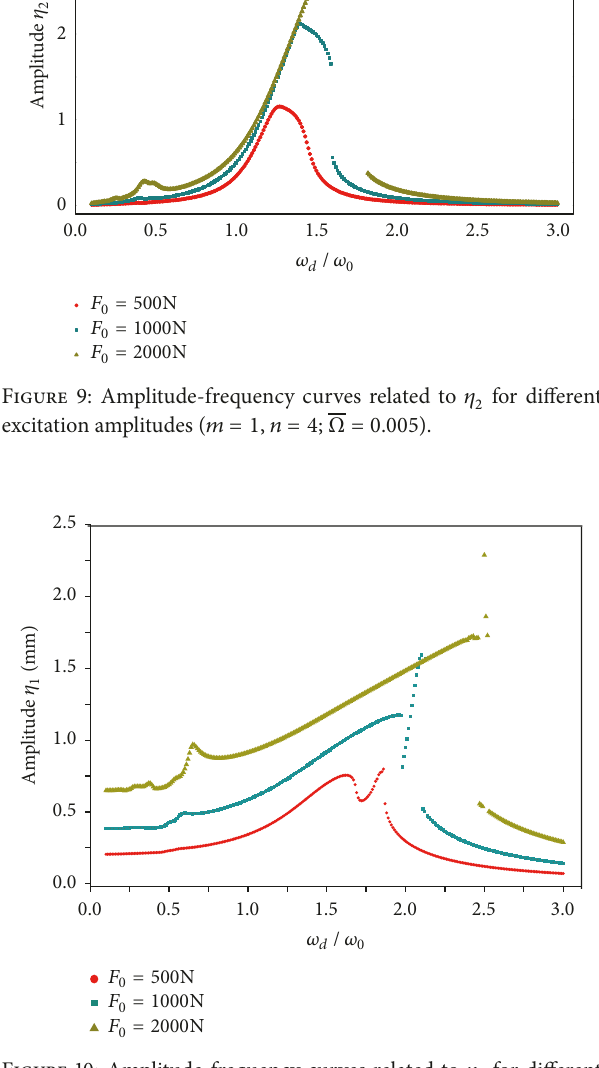
Figure 10: Amplitude-frequency curves related to 𝜂 1 for different excitation amplitudes.( 𝑚 = 1 , 𝑛 = 5 ; Ω = 0.005